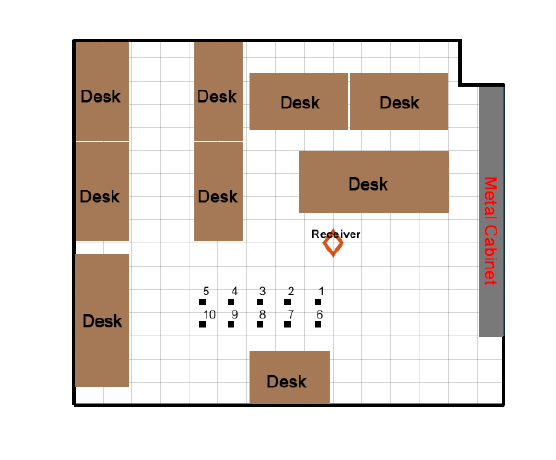
Figure 6. Layout of the test